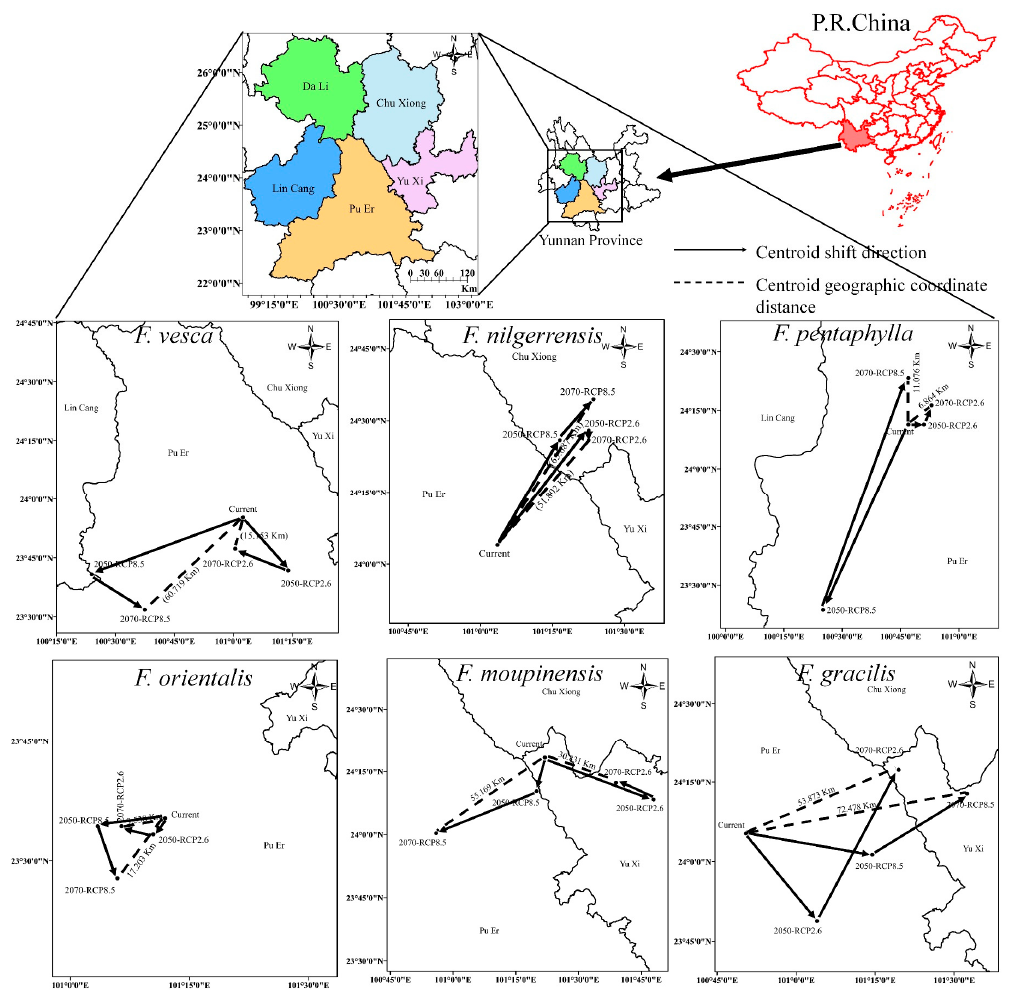
Figure 6. Variations in the centroid coordinates of suitable areas for six wild strawberry species under different climate scenarios in the biodiversity hotspot of Yunnan Province, China. “Current” represents current scenario (1970 to 2000); “RCP2.6” represents the minimum greenhouse gas scenario, and “RCP8.5” represents the maximum greenhouse gas scenario; “2050” and “2070” represent two periods of the 2050s (2041 to 2060) and 2070s (2061 to 2080), respectively.